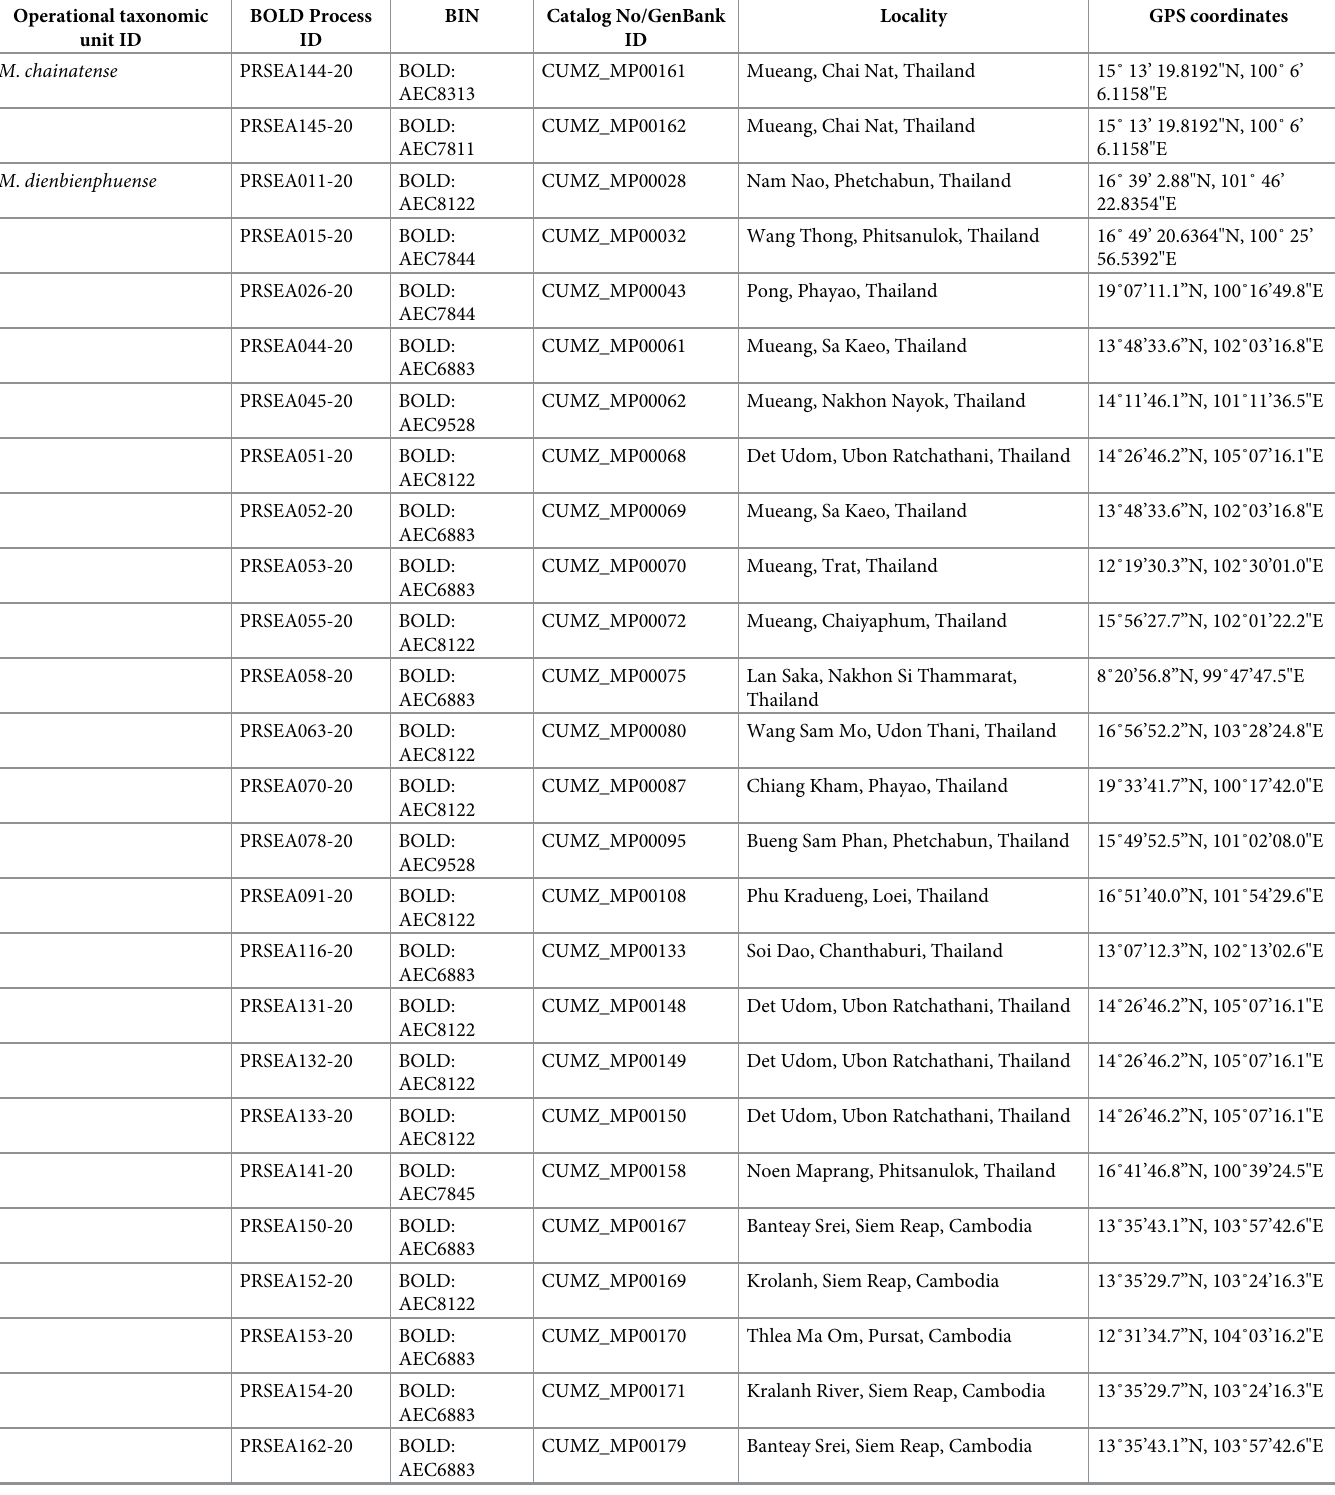
Table 2. Macrobrachium species samples used in this study including previously deposited sequences from BOLD. Operational taxonomic unit